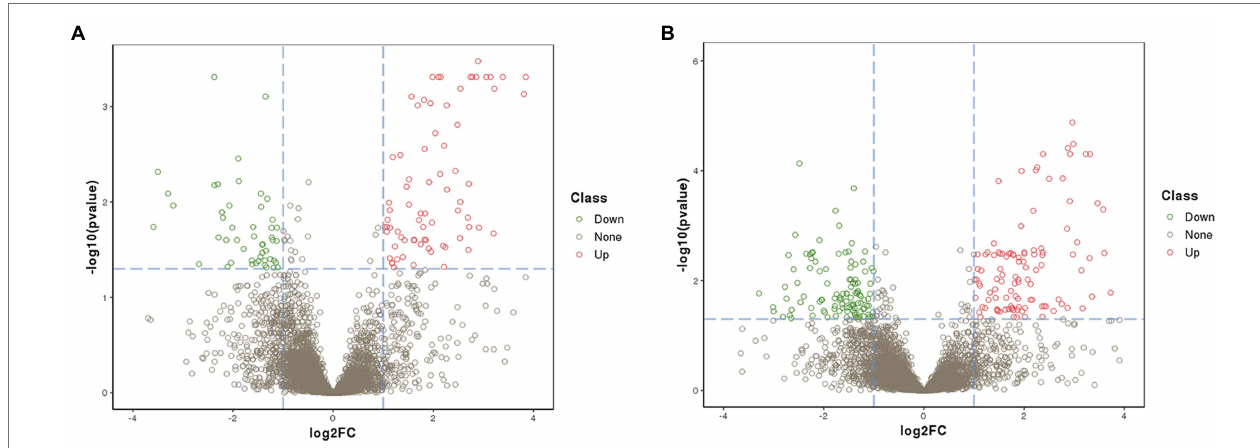
FIGURE 3 | Volcano map of differentially accumulated proteins (DAPs) in two different peanut cultivars after 12 days of waterlogging treatment. (A) Volcano map of DAPs between ZH4 and its control group after 12 days of waterlogging treatment. (B) Volcano map of DAPs between XH08 and its controls after 12 days of waterlogging treatment.